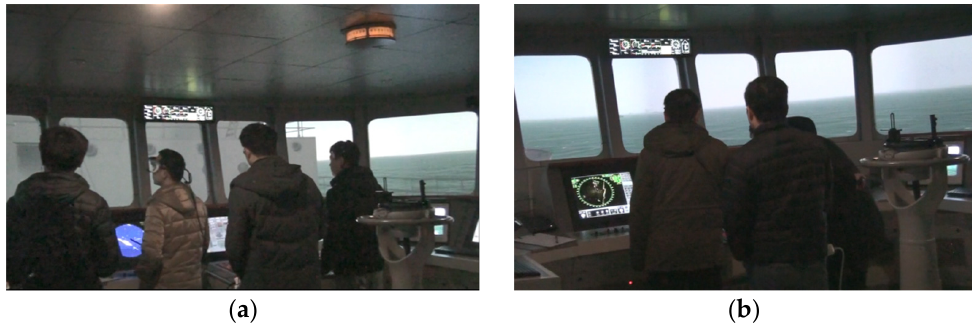
Figure 4. A part of the real experimental scenarios ( a ) ship encounter ( b ) adverse weather.